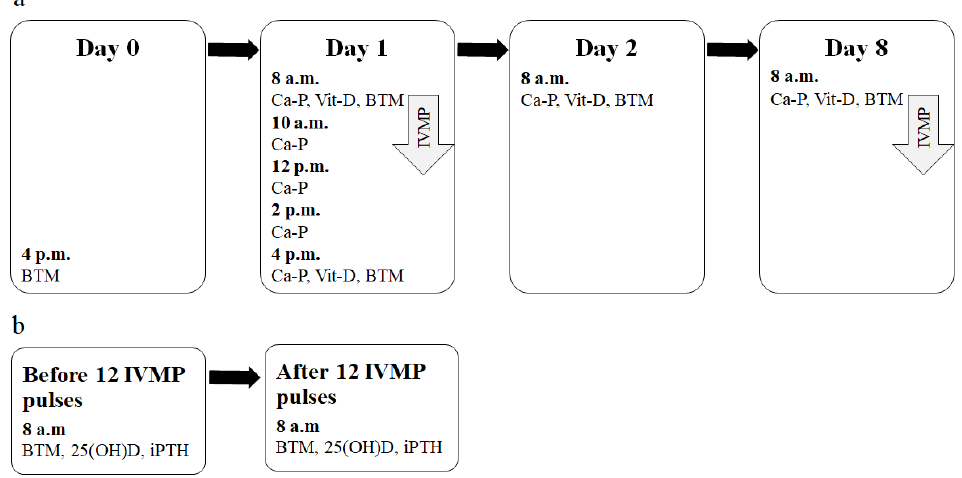
Figure 1. The scheme of the study design. ( a ) Early evaluation time-points and parameters measured (after a single IVMP pulse). ( b ) Further evaluation time-points and parameters measured (after